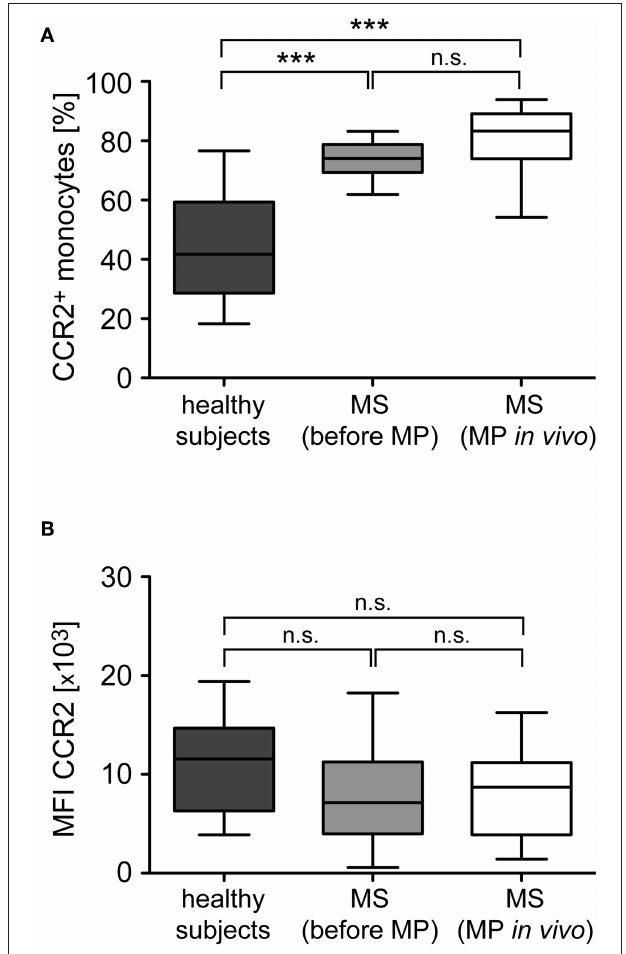
FIGURE 8 | Analysis of CCR2 surface expression levels in monocytes from healthy subjects and MS patients before and after GC treatment in vivo . Monocytes were isolated from healthy subjects as well as MS patients before and 24h after MP pulse therapy in vivo . CCR2 surface expression was analyzed by flow cytometry and subsequently the percentage of CCR2 + monocytes (A) and the surface level of CCR2 based on the mean fluorescence intensity (MFI) were determined (B) . Data are presented as box-and-whiskers plots showing the minimum, maximum and median; n = 13/22/17. Statistical analysis was performed using a One-way ANOVA and Newman-Keuls Multiple Comparison test. Levels of significance: n.s. p ≥ 0.05; *** p <